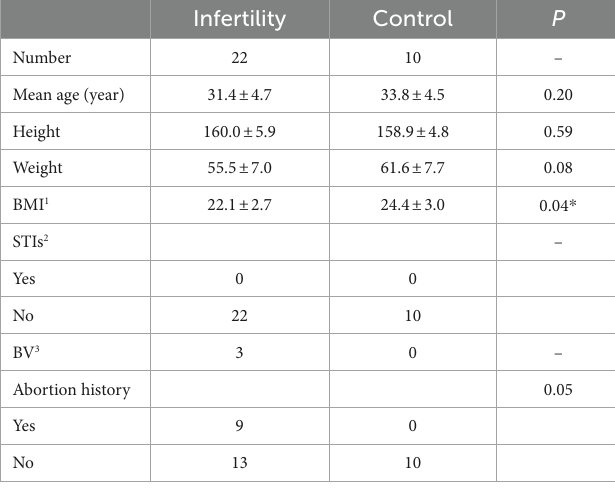
TABLE 1 The baseline characteristics of the